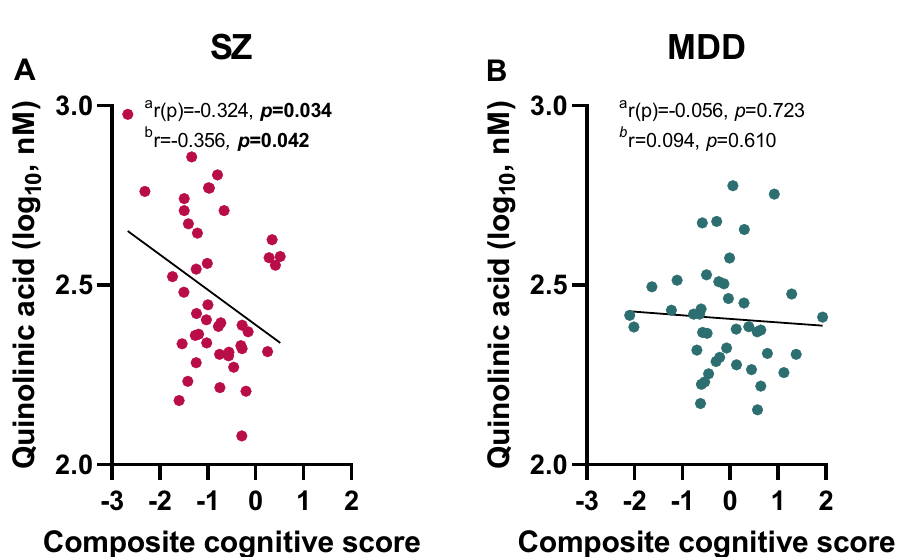
Figure 2. Correlations between quinolinic acid and composite cognitive score in patients with schizophrenia (SZ) and major depressive disorder (MDD). Significant negative correlations between quinolinic acid and composite cognitive score in patients with ( A ) SZ but not ( B ) MDD. Higher cognitive scores indicate better cognitive performance. a Without correcting for covariates, b After correction for the covariates age, sex, BMI, smoking, disease severity (i.e. illness onset and duration), medication (chlorpromazine equivalents, imipramine equivalents, lorazepam medication) and total years of education. The level of significance was set at p < 0.05 (significant p-values are indicated in